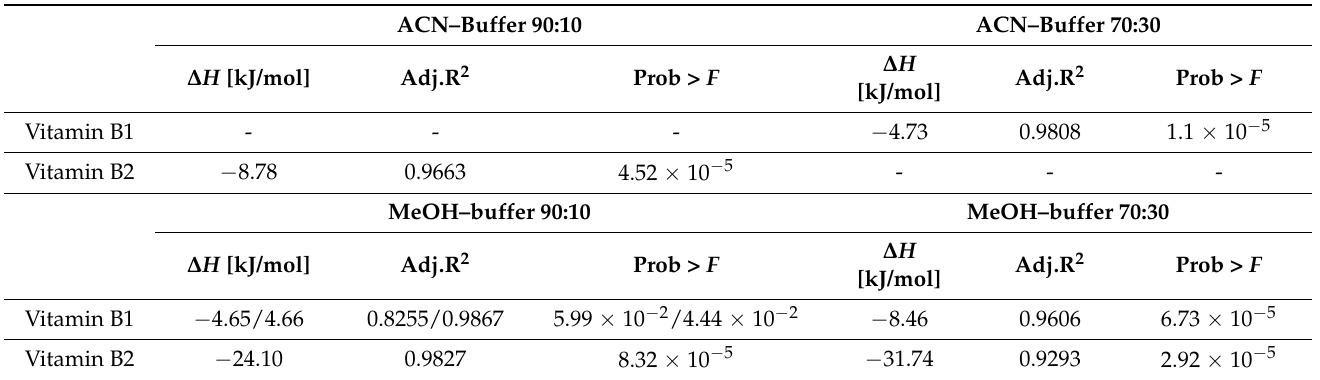
Table 2. Van’t Hoff equation regression data for analytes in column A for different mobile phase com- positions.